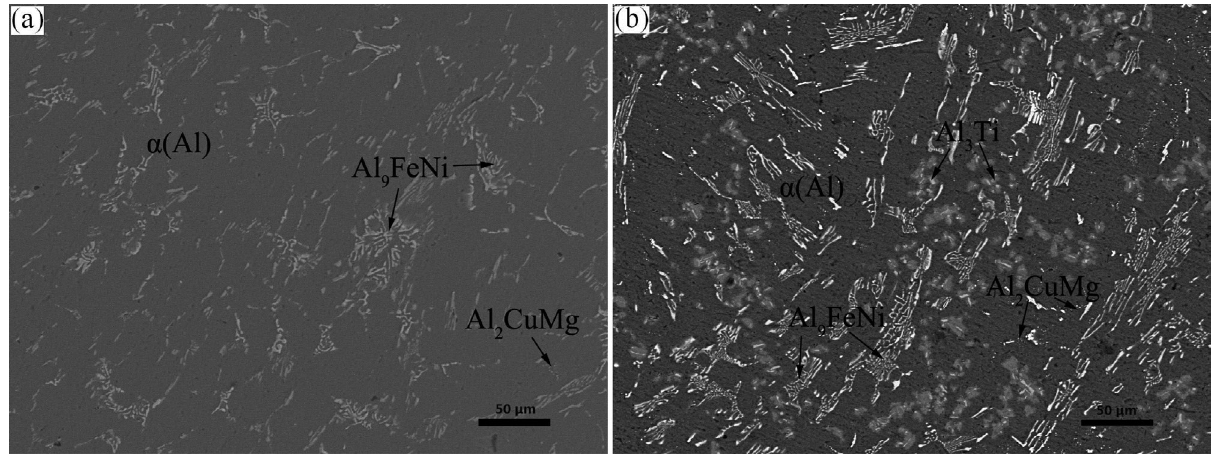
Fig. 7: The homogenization microstructures of alloy 2618 and alloy